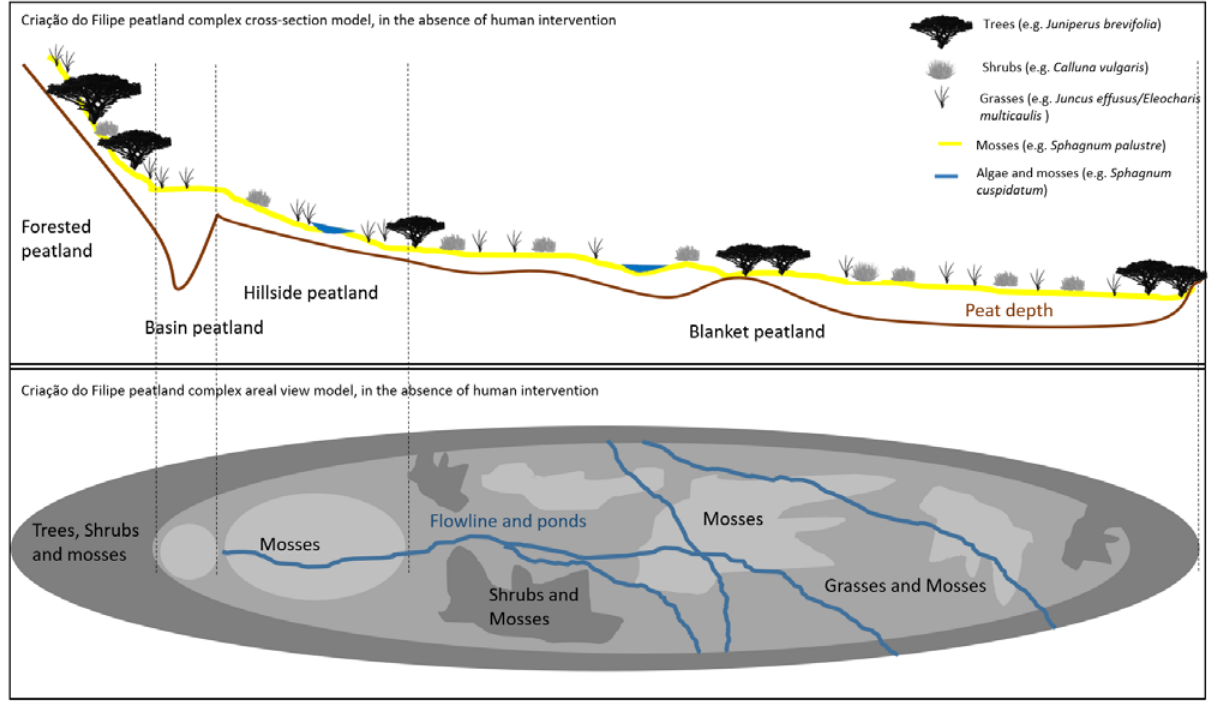
Figure 9. Pico da Criação do Filipe peatland complex before human intervention, based on theoretical modelling. From A to C' (left to right) considering Figure